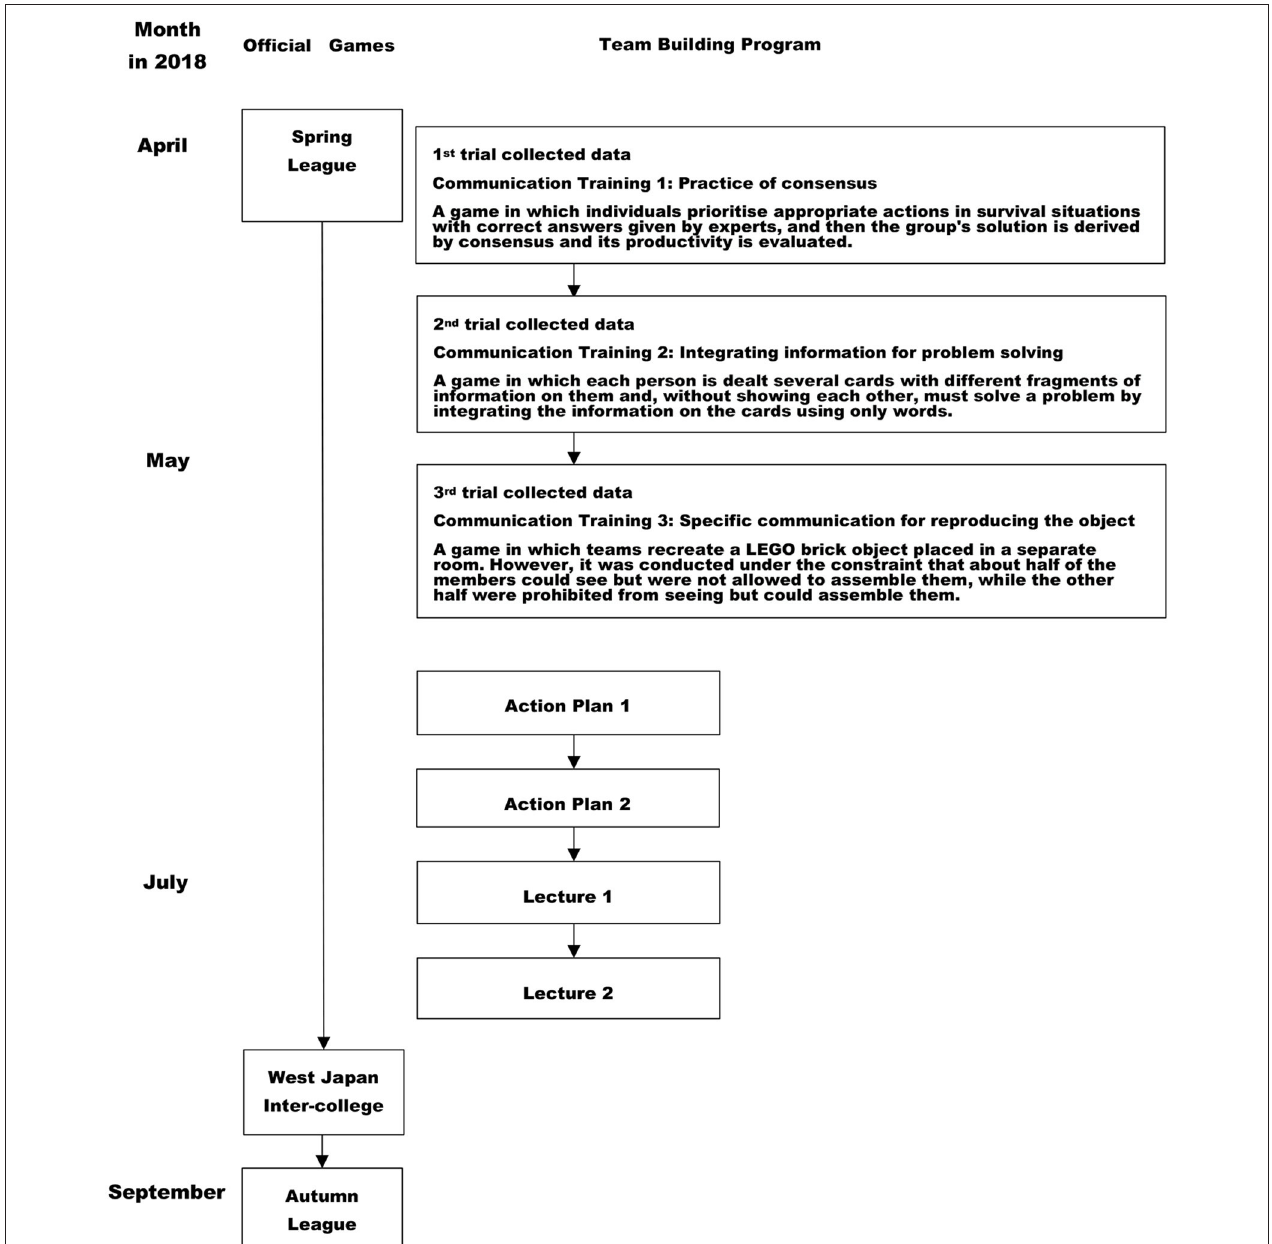
FIGURE 2 | Trials in the team building